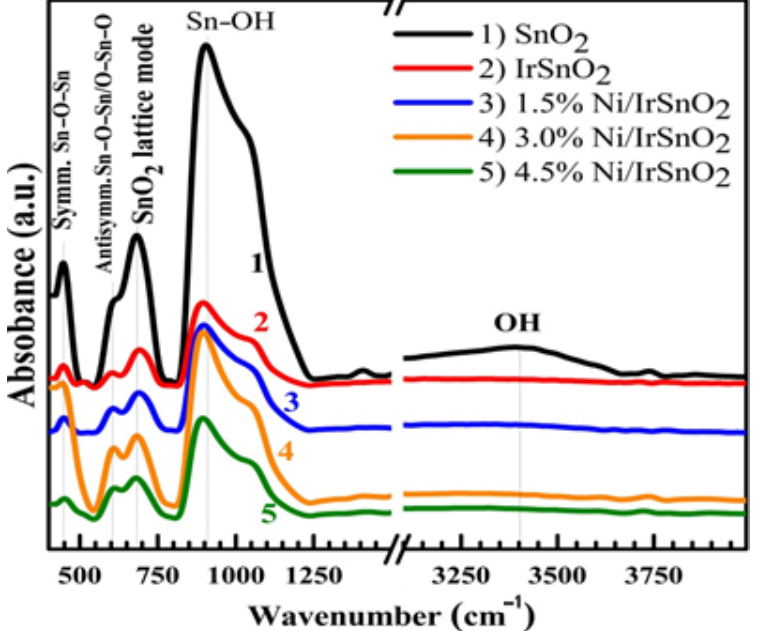
Figure 3. FTIR absorption spectra of SnO 2 , 3.0% Ir-doped SnO 2 (SnO 2 :Ir) and SnO 2 :Ni,Ir.